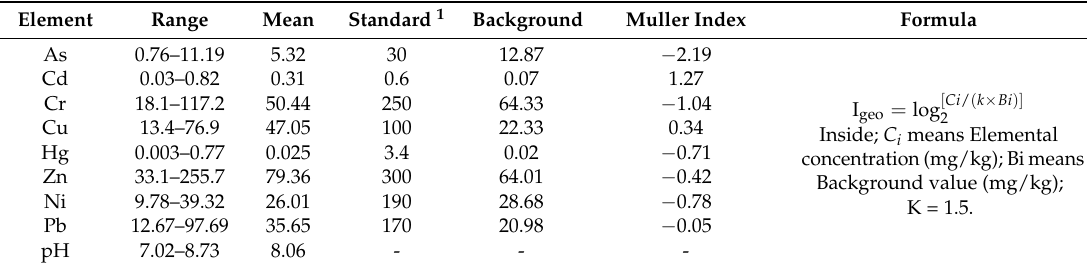
Table 4. Summary statistics of Potentially Toxic Elements in soil (mg/kg) ( n = 71).